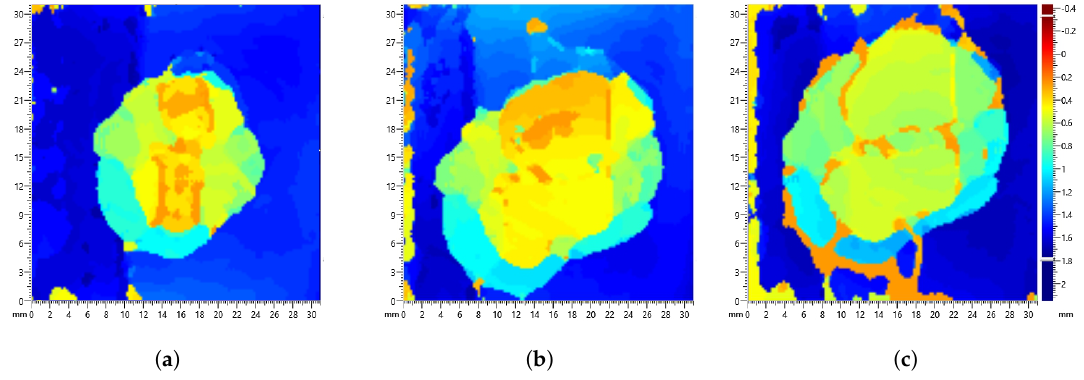
Figure 16. C-scan of BVID on the SHM layer CFRP panel for each impact event, with increasing energy